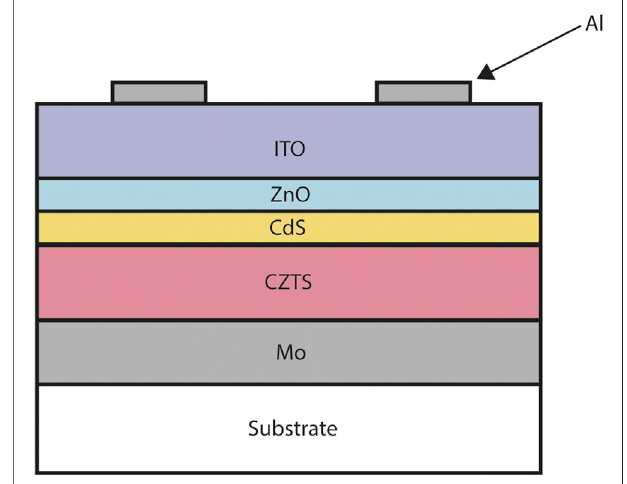
FIGURE 5 | Typical copper zinc tin sul fi de (CZTS) solar cell cross- section. From top to bottom: nickel and aluminium front contact grid, indium tin oxide (ITO), intrinsic zinc oxide (ZnO), cadmium sulfate (CdS), copper zinc tin sul fi de (CZTS), molybdenum (Mo), soda lime glass substrate. The layer widths are not to